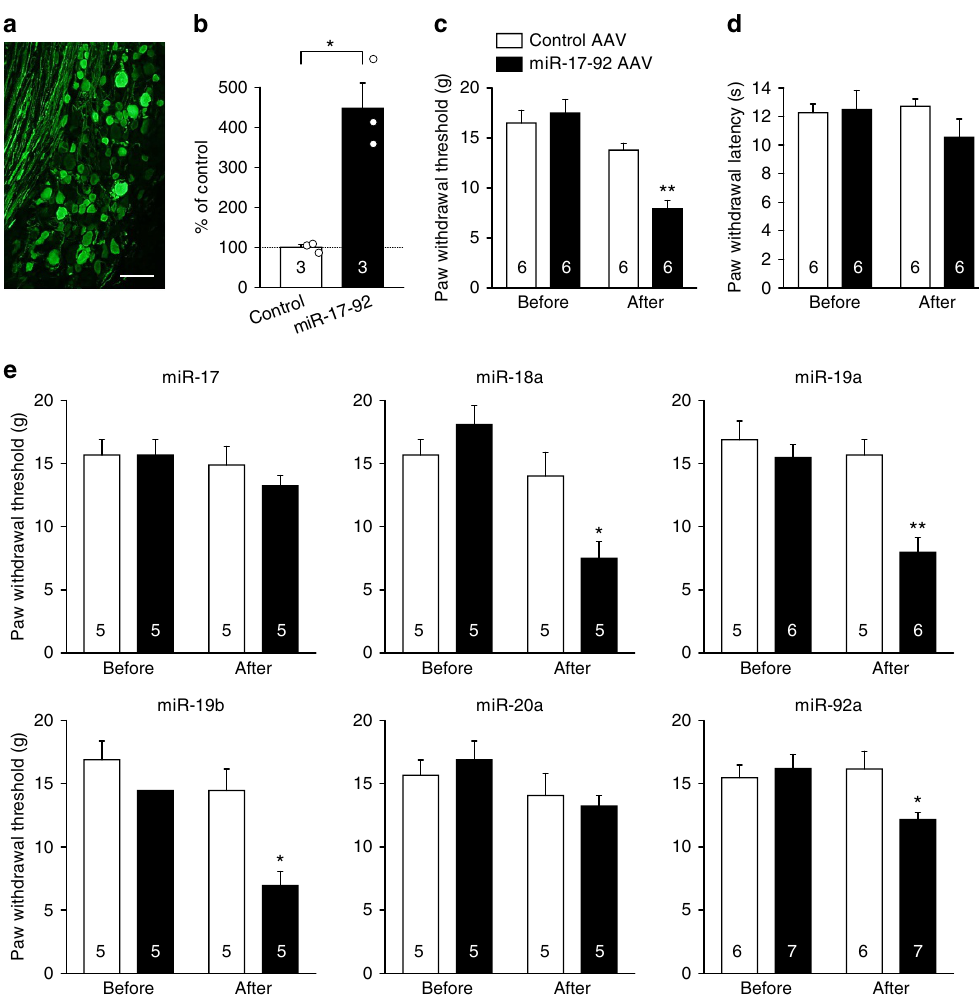
Figure 2 | miR-17-92 cluster overexpression in DRG neurons causes mechanical allodynia. ( a ) Representative image of EGFP immunofluorescence in the L5 DRG 7 days after injection of the AAV vector encoding miR-17-92 and EGFP. Scale bar, 100 m m. ( b ) Expression levels of miR-17-92 primary transcript in L5 DRGs 7 days after control or miR-17-92 AAV vector injection. Numbers of samples are indicated at the base of each bar. * P ¼ 0.031 by Welch’s test. ( c – e ) Paw withdrawal threshold ( c , e ) and latencies ( d ) to mechanical and thermal stimuli, respectively, were evaluated on the injected sides before and 7 days after the injection of AAV vector encoding the whole miR-17-92 cluster ( c , d ) or individual miR-17-92 cluster members ( e ). Error bars are s.e.m. * P o 0.05 and ** P o 0.01 ( P ¼ 0.004 for miR-17-92; P ¼ 0.023 for miR-18a; P ¼ 0.004 for miR-19a; P ¼ 0.008 for miR-19b; P ¼ 0.014 for miR-92) compared with the control injection, Mann–Whitney U